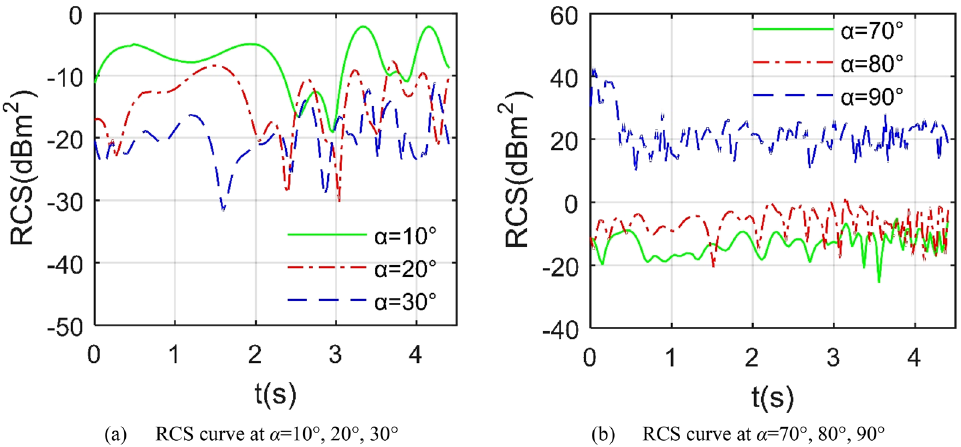
Figure 13. RCS of the aircraft in Z3 mode under various azimuths, β = 0°, f RH = 6 GHz, ω m1 = ω m2 = 0.1963 rad/s.